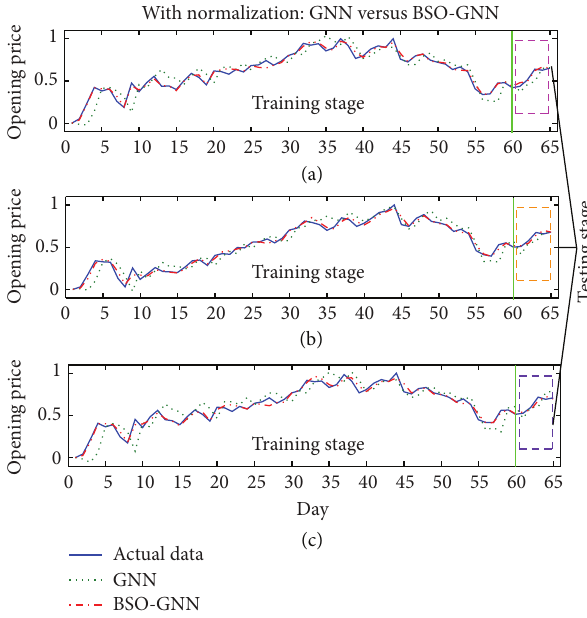
Figure 4: Opening price fitting and forecasting results of the three stock market indices gained by the individual GNN model and the BSO-GNN model under the nonnormalization situation: (a) SSE Composite Index, (b) Shenzhen Composite Index, and (c) HuShen 300 Index.